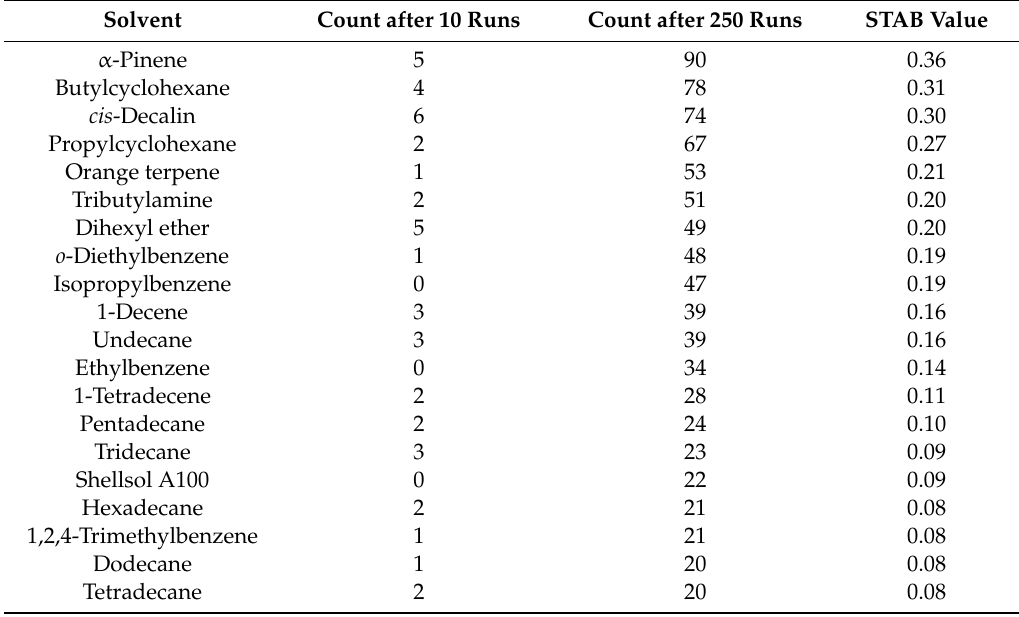
Table 8. Candidate list for limonene. Neighbor counts after 10 and 250 runs and STAB (stability)